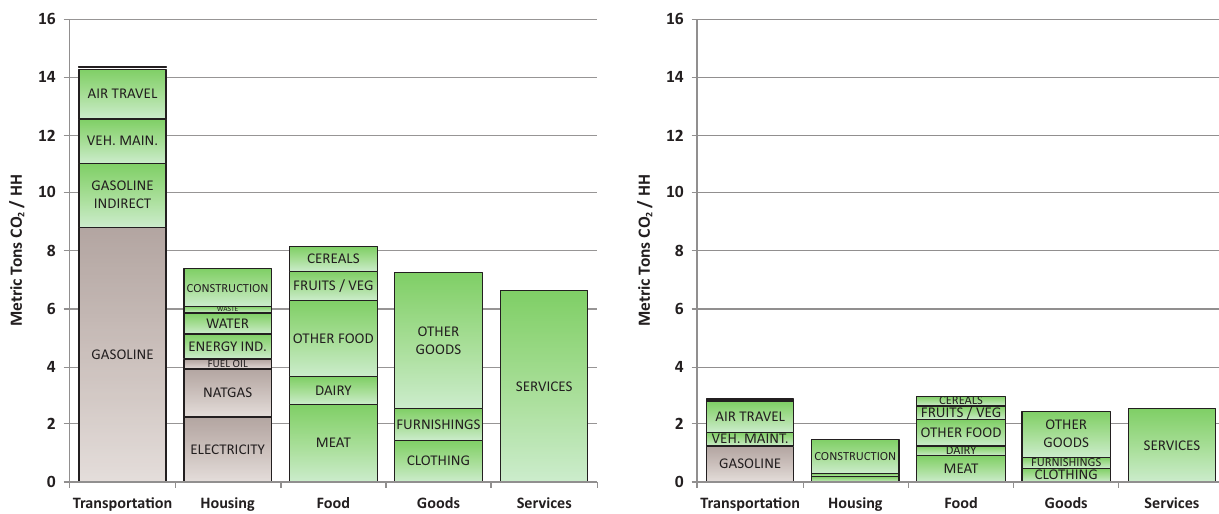
Figure 1. Carbon footprint of average California household in 2010 and 2050 under deep GHG abatement. Green colored bars are indirect emissions from the life cycle of products and services that are not typically covered in production-based inventories (unless produced